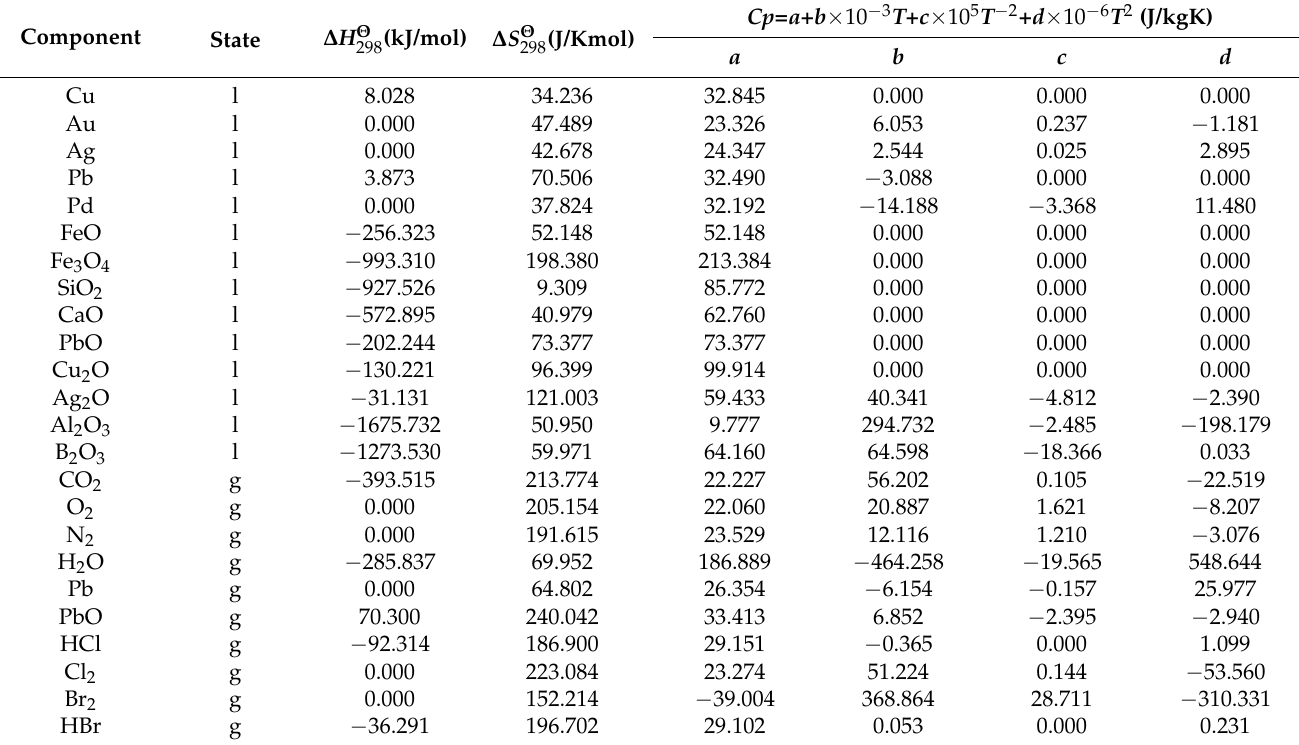
Table 2. The Standard formation Gibbs free energy of component [39].